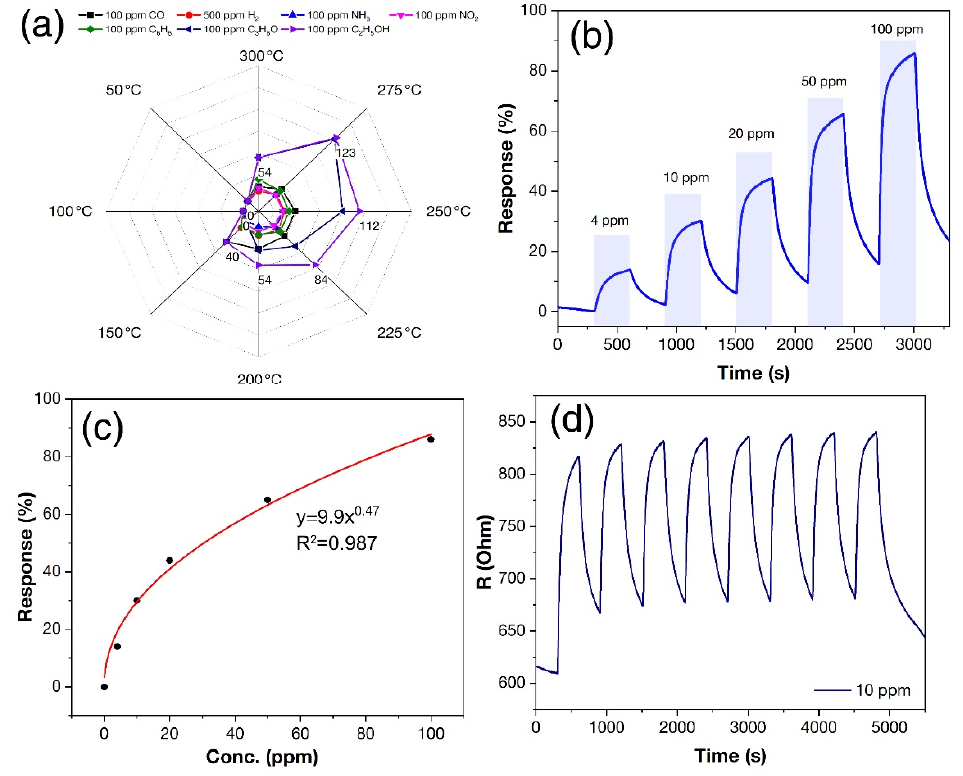
Figure 11. Selectivity diagram to different gases at an operating temperature of 50–300 °C ( a ), sensor response to 4–100 ppm ethanol at 225 ◦ C ( b ), sensor response dependence on ethanol concentration response to 4–100 ppm ethanol at 225 °C ( b ), sensor response dependence on ethanol concentration at 225 °C ( c ), signal reproducibility when detecting 10 ppm ethanol at 225 °C ( d ). at 225 ◦ C ( c ), signal reproducibility when detecting 10 ppm ethanol at 225 ◦ C ( d